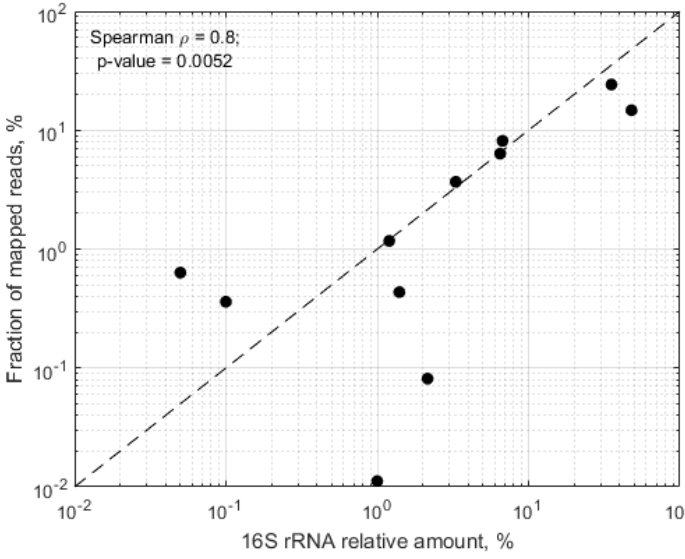
Figure 3. Correlation between 16S rRNA relative abundance and RMS estimates of expected target species in samples where >50% of the mapped regions corresponded to the in silico predicted RMS